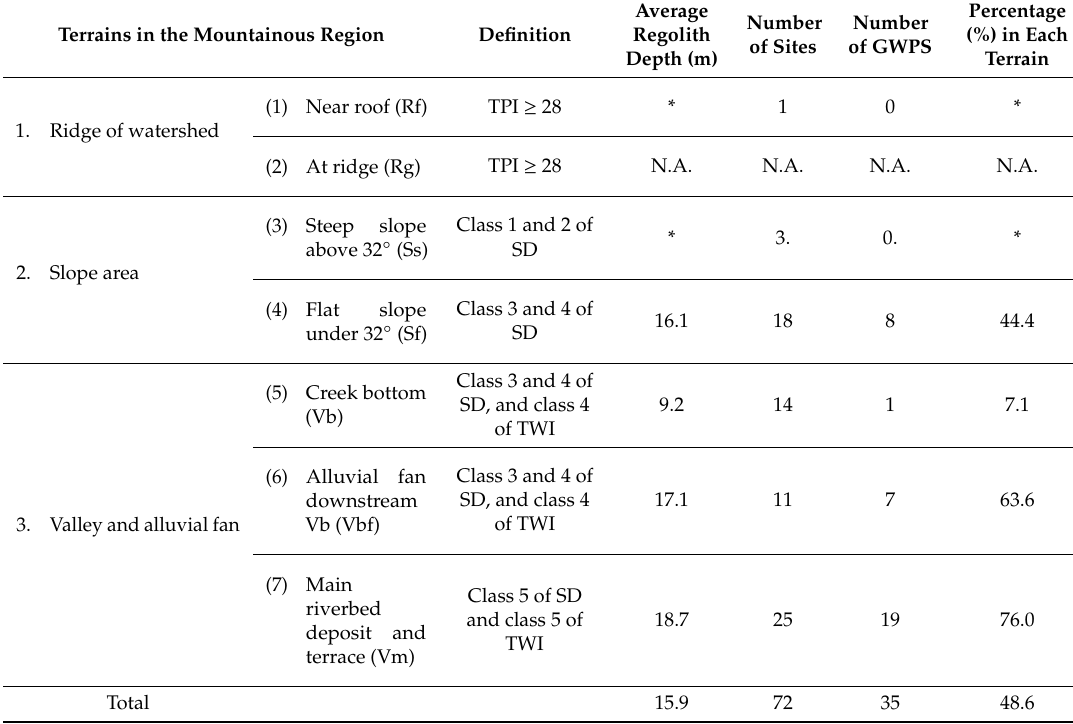
Table 7. Statistics of regolith depth and GWPS in delineated